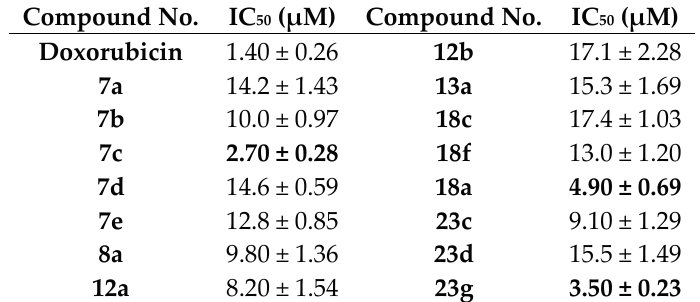
Table 1. Cytotoxic activities of tested compounds against liver carcinoma cell line (HEPG2-1). Compound